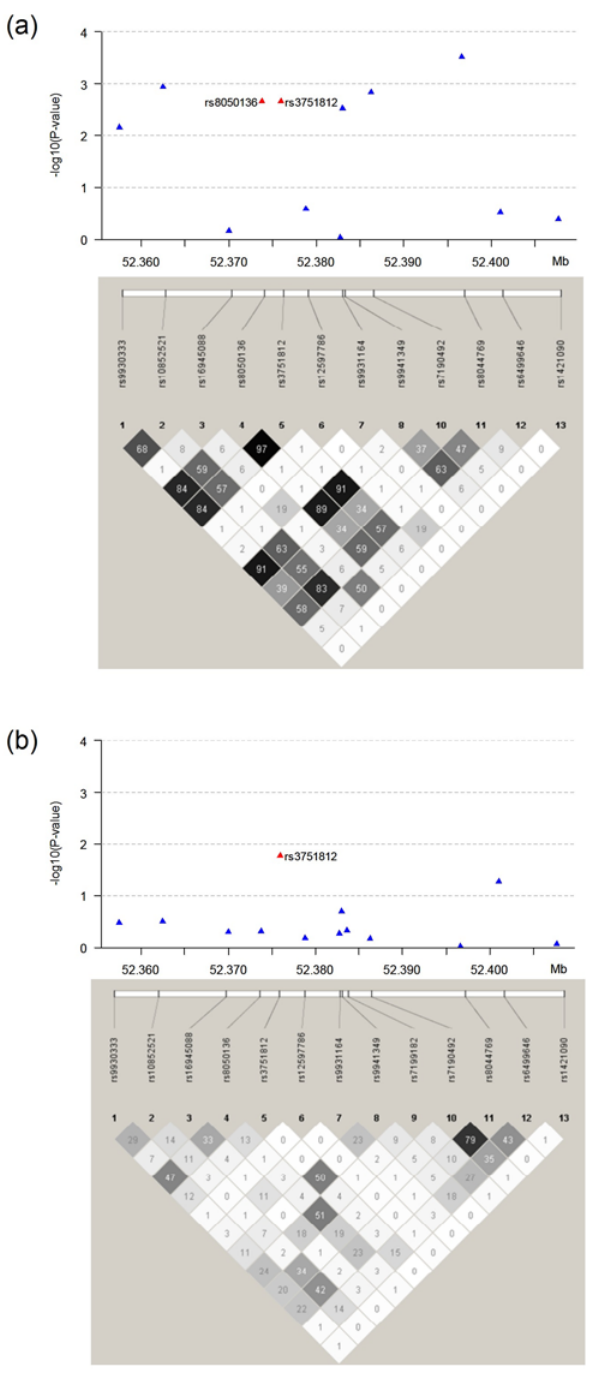
Figure 1. Linkage disequilibrium (r 2 ) between SNPs at the FTO locus in (a) Caucasians and (b) African Americans: Plotted are 2 log10(P-value) of allelic chi-squared tests. The strength of linkage disequilibrium (r 2 ) between SNPs is represented both numer- ically and by the depth of shading